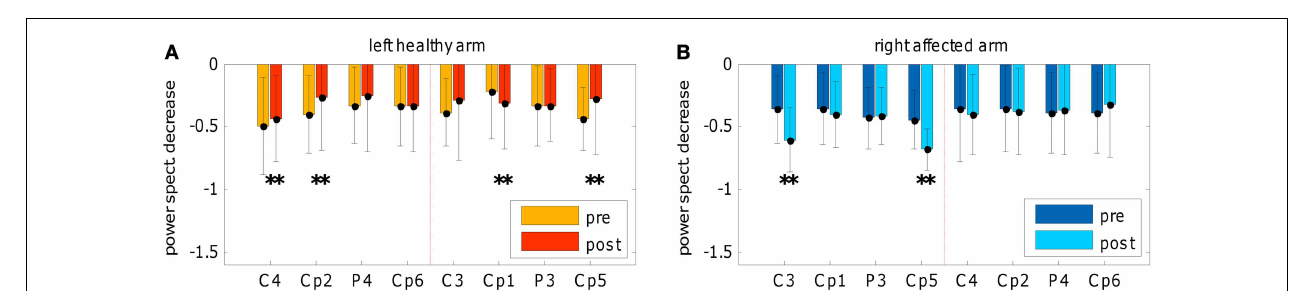
spectral power of the rest condition allows a comparison between pre- and post-evaluations by means ofWilcoxon test (for the number of pre- and post-evaluations trials see Figure 4 description). Electrodes showing the largest effects are slightly different than those showed in Figure 4 because the normalized computation is different from R 2 estimation (see the cross-check method explained in Section “EEG Off-Line Data Processing”). In addition, significant changes of power decrease referred to the comparison between pre- and